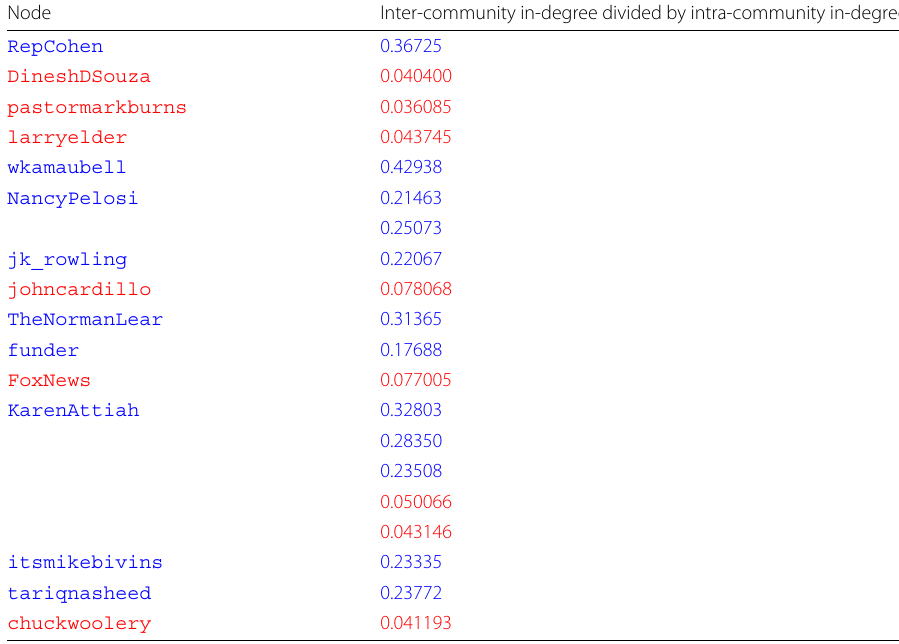
for the 20 most heavily retweeted nodes in the retweet network